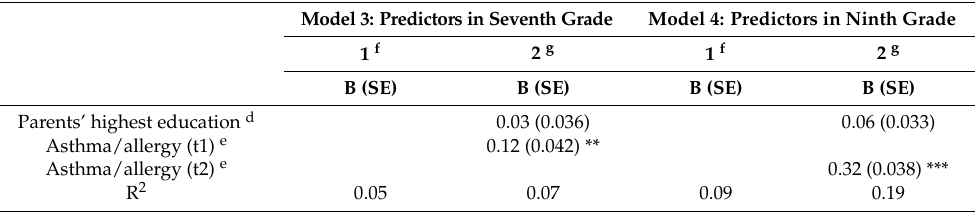
Table 4. Cont. Model 3: Predictors in Seventh Grade Model 4: Predictors in Ninth